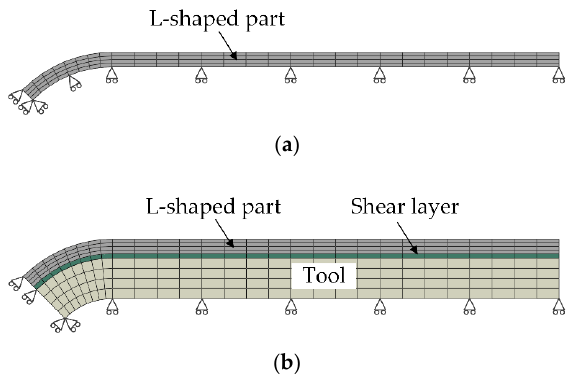
Figure 3. Simulation calculation process of numerical model.